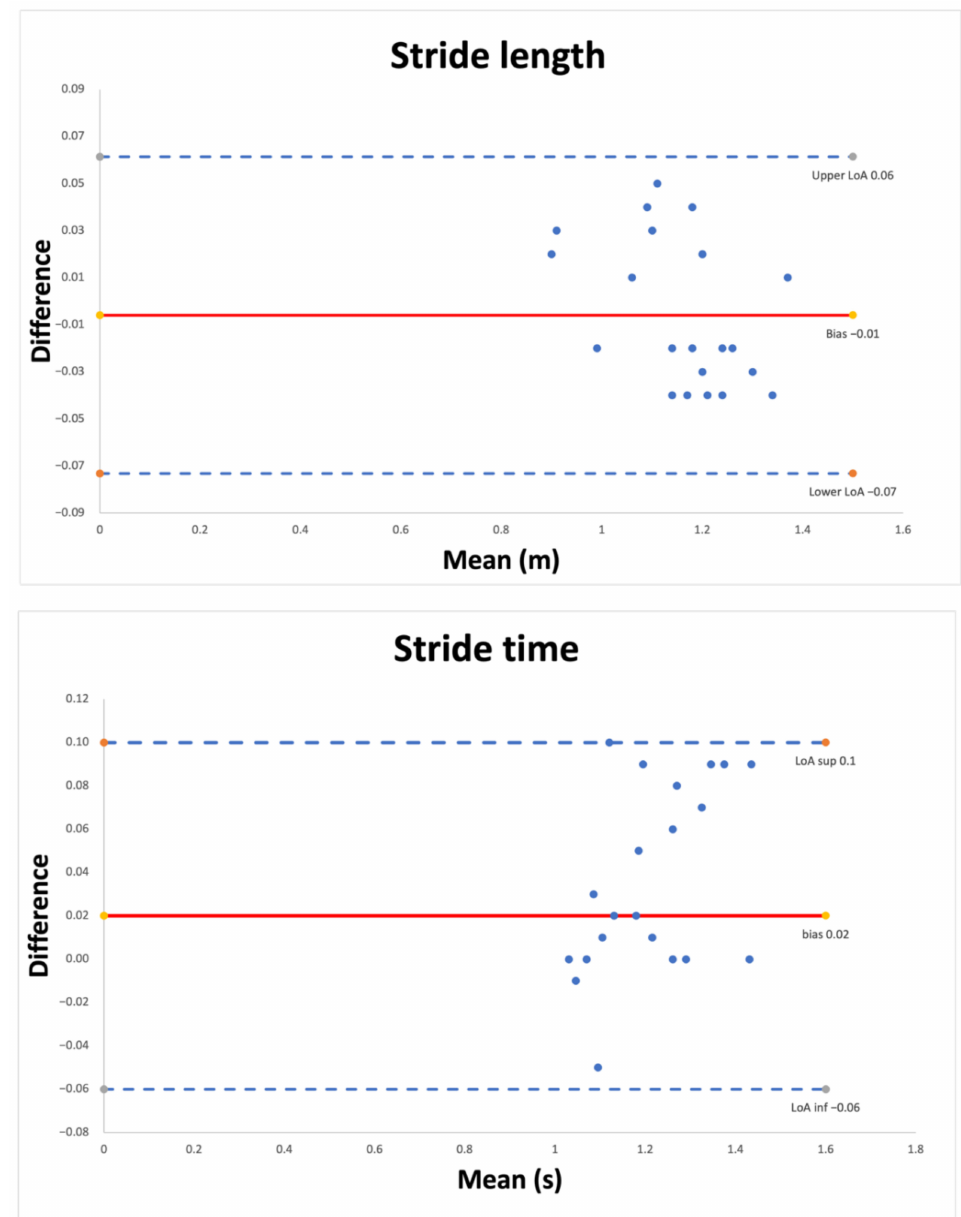
Figure 2. Bland-Altman plots for stride length and stride time. Each graph presents the mean difference (solid line) and 1.96-fold standard deviation of difference (dashed line) indicating the limits of agreement between the